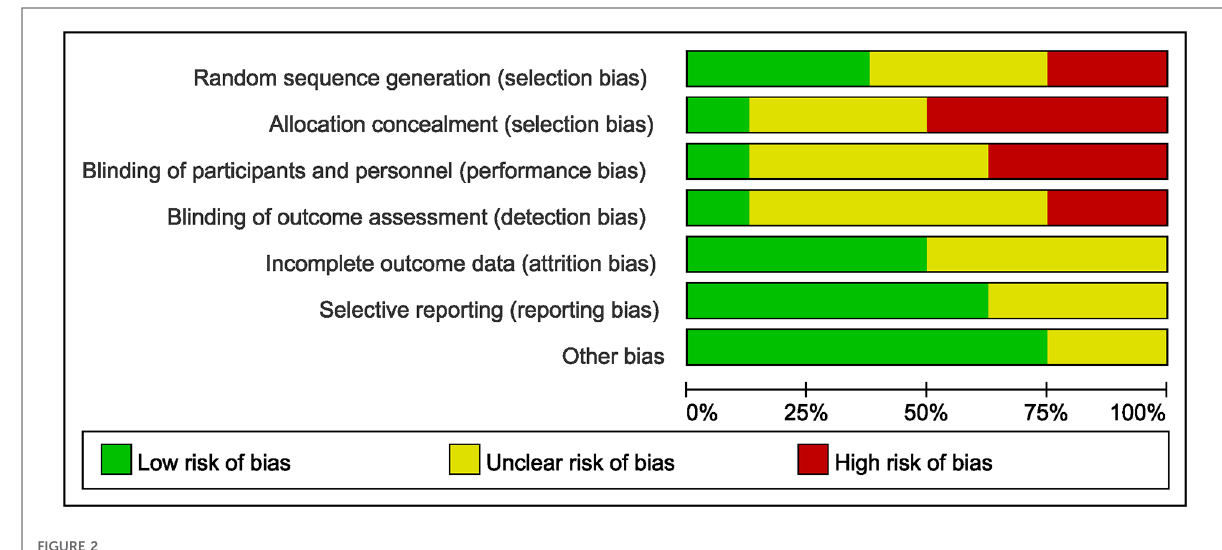
FIGURE 2 Results of quality assessment using cochrane risk of bias tool for RCTs.